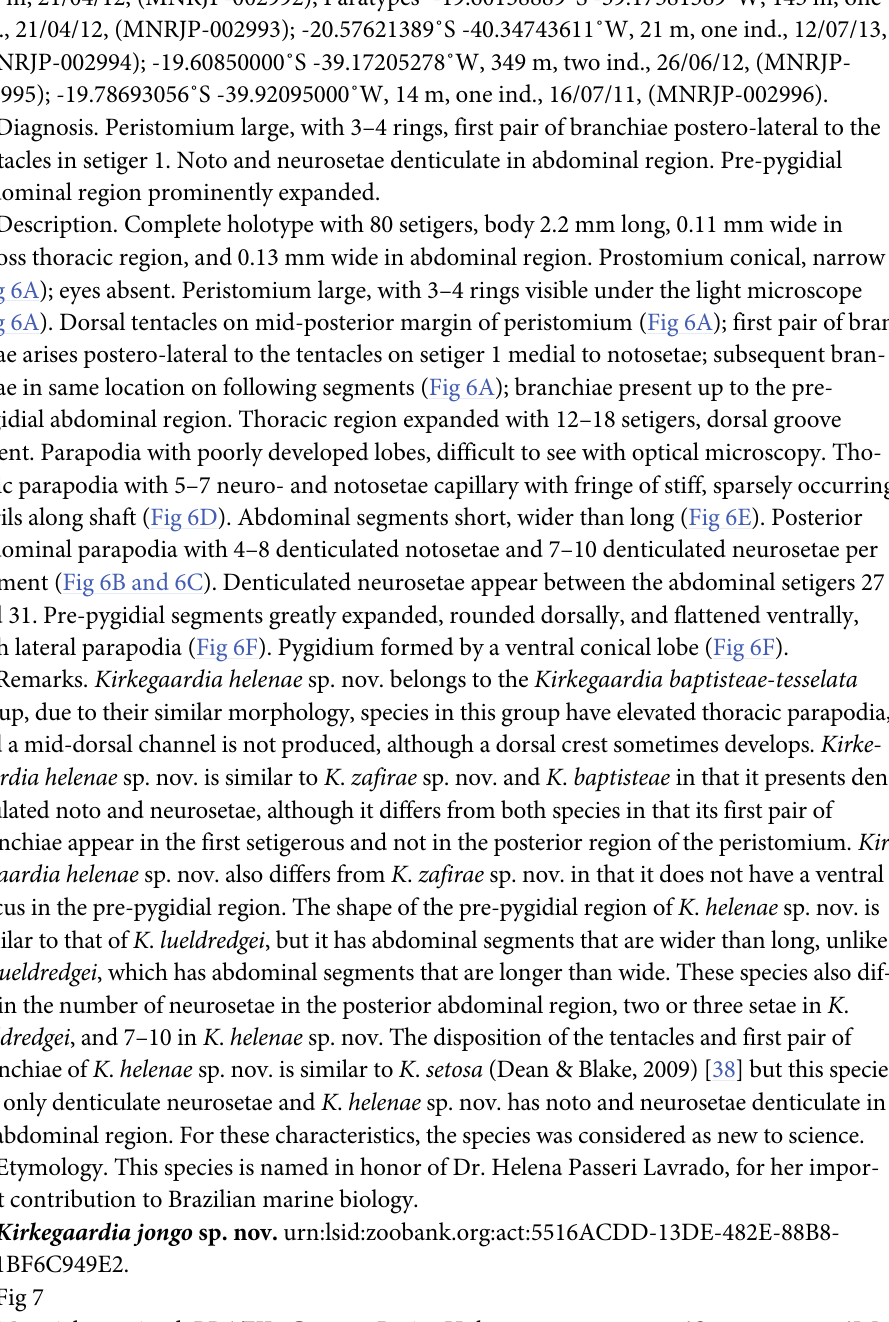
Fig 7 Material examined. BRAZIL: Campos Basin–Holotype–-20.06893889˚S -38.52425556˚W, 1288 m, 21/12/11, (MNRJP-002997); Paratypes–-20.60056389˚S -39.85982500˚W, 991 m,